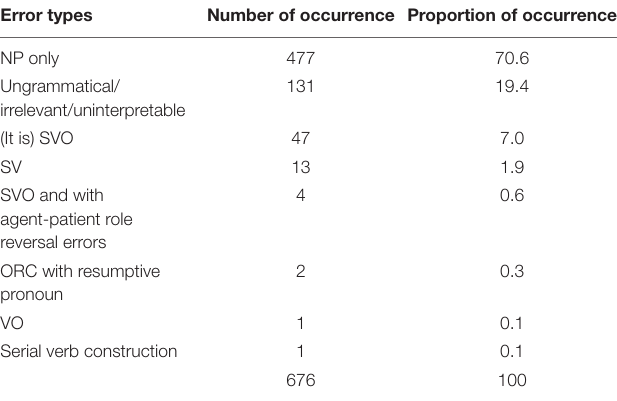
TABLE 6 | Distribution of error types in the ORC